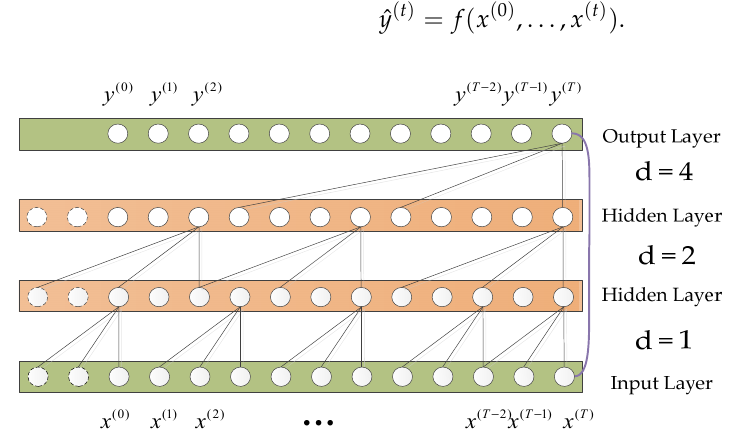
Figure 2. Schematic of the TCN.